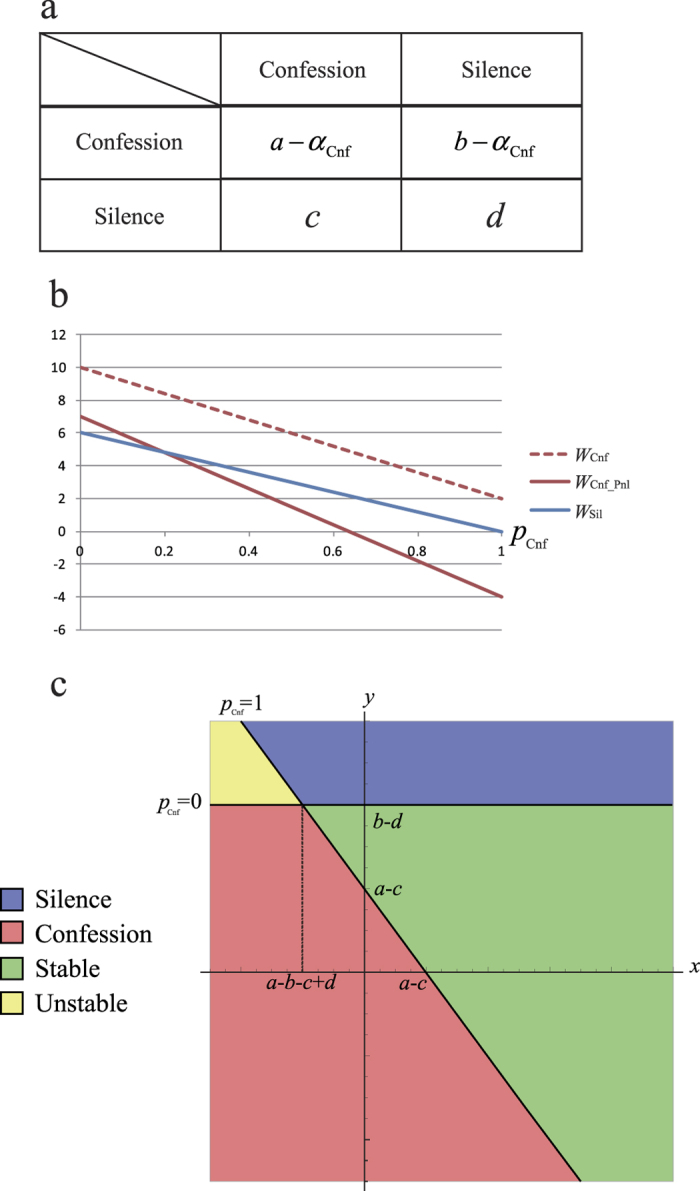
Social penalty introduced into the prisoner’s dilemma game.(a) Payoff matrix of a prisoner’s dilemma game include social penalty αCnf. (b) The average payoffs (W) of confession and silence. Values of WCnf (p), WCnf_Pnl (p), and WSil (p) are plotted against the frequency p of confession. The intersections determine a stable mixed strategy ESS (a = 2, b = 10, c = 0, d = 6, x = 3, y = 3). (c) The phase diagram of x and y. Outcomes depend on penalty parameters: pure Silence (blue), pure Confession (Red), stable mixed strategy ESS (Green), and non-ESS Nash equilibrium (Yellow).